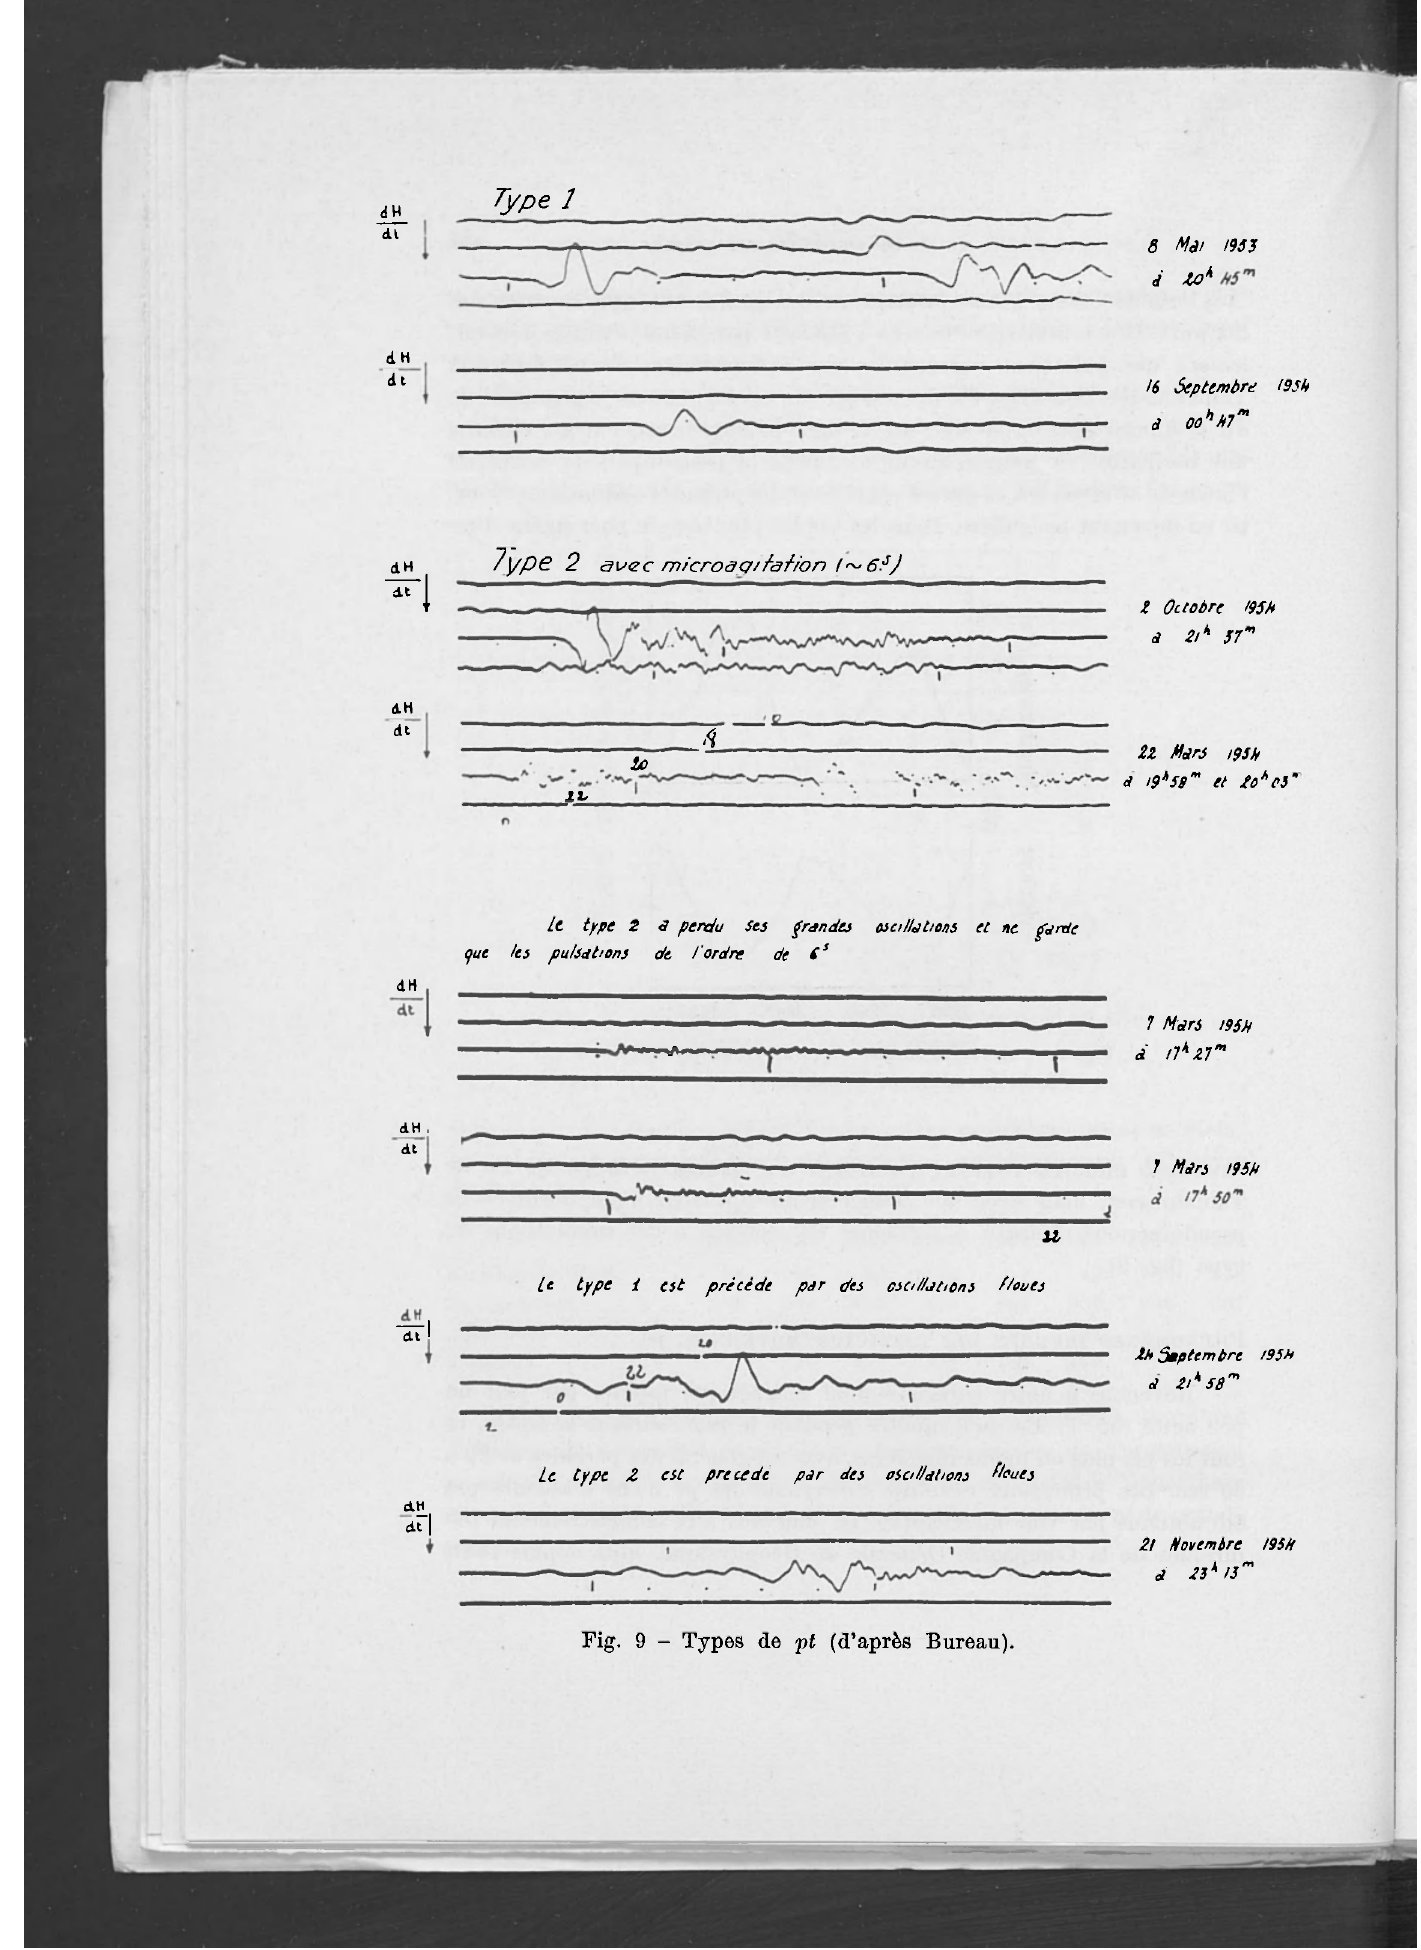
Fig. 9 - Types de pt (d'après